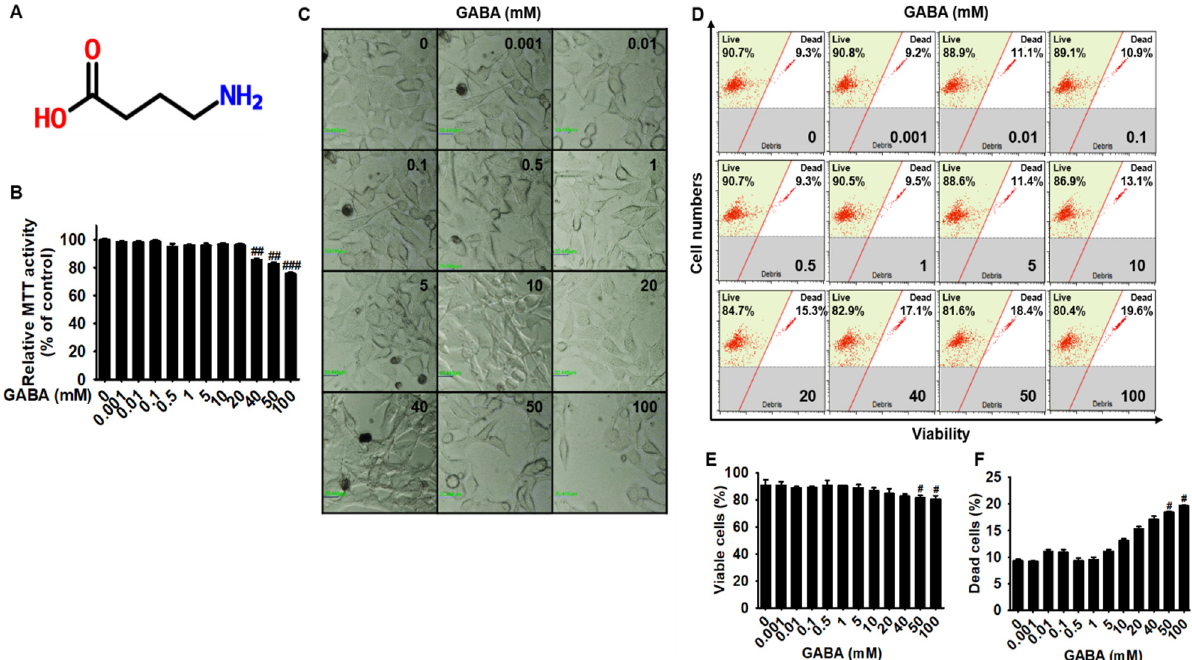
Figure 1. Low concentrations of GABA show no cytotoxicity in B16F10 melanoma cells. B16F10 melanoma cells (5 × 10 4 cells/mL) were treated with the indicated concentrations of GABA (0–100 mM) for 96 h. ( A ) Chemical structure of GABA. ( B ) Cell viability was measured using an MTT assay. ( C ) Cellular morphology was observed using phase-contrast microscopy (× 20). Scale bars = 20 µm. ( D ) Cell viability and dead cell populations were measured using Muse Cell Viability kit. Viable and ( E ) dead cell ( F ) populations are shown. Significant differences among the groups were determined using one-way ANOVA followed by Bonferroni correction. All data are presented as the standard error of the median from three independent experiments ( ### p < 0.001, ## p < 0.01, and # p < 0.05 vs. the untreated cells). GABA, gamma-aminobutyric acid.